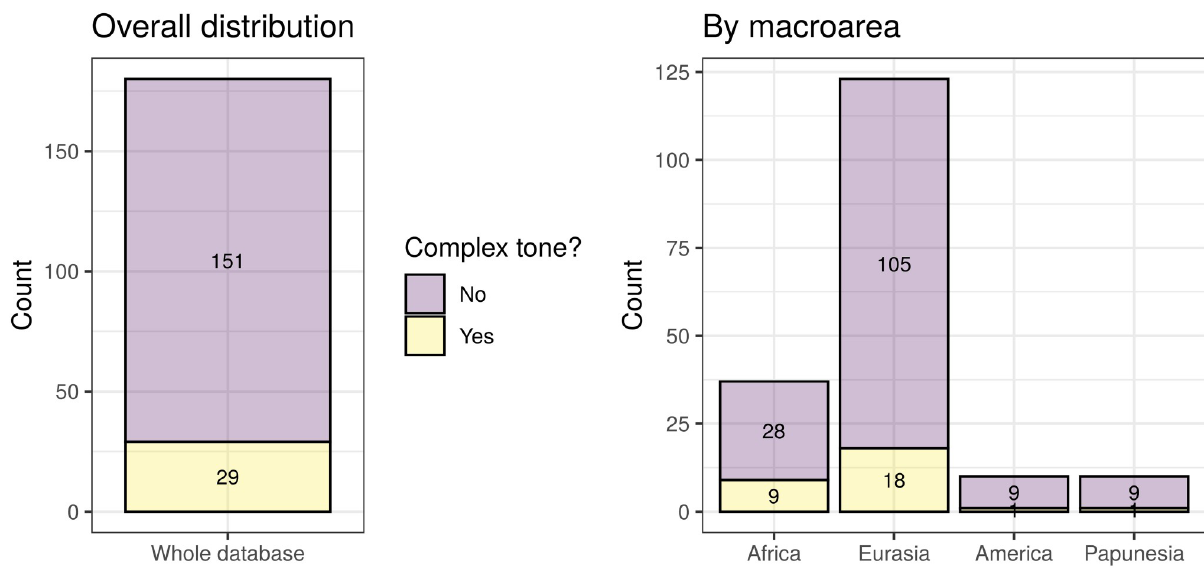
Fig 16. Distribution (as counts) of tone2 (no and simple tone vs complex tone) across the full database (left) and by macroarea (right). Same conventions as in Fig 7.